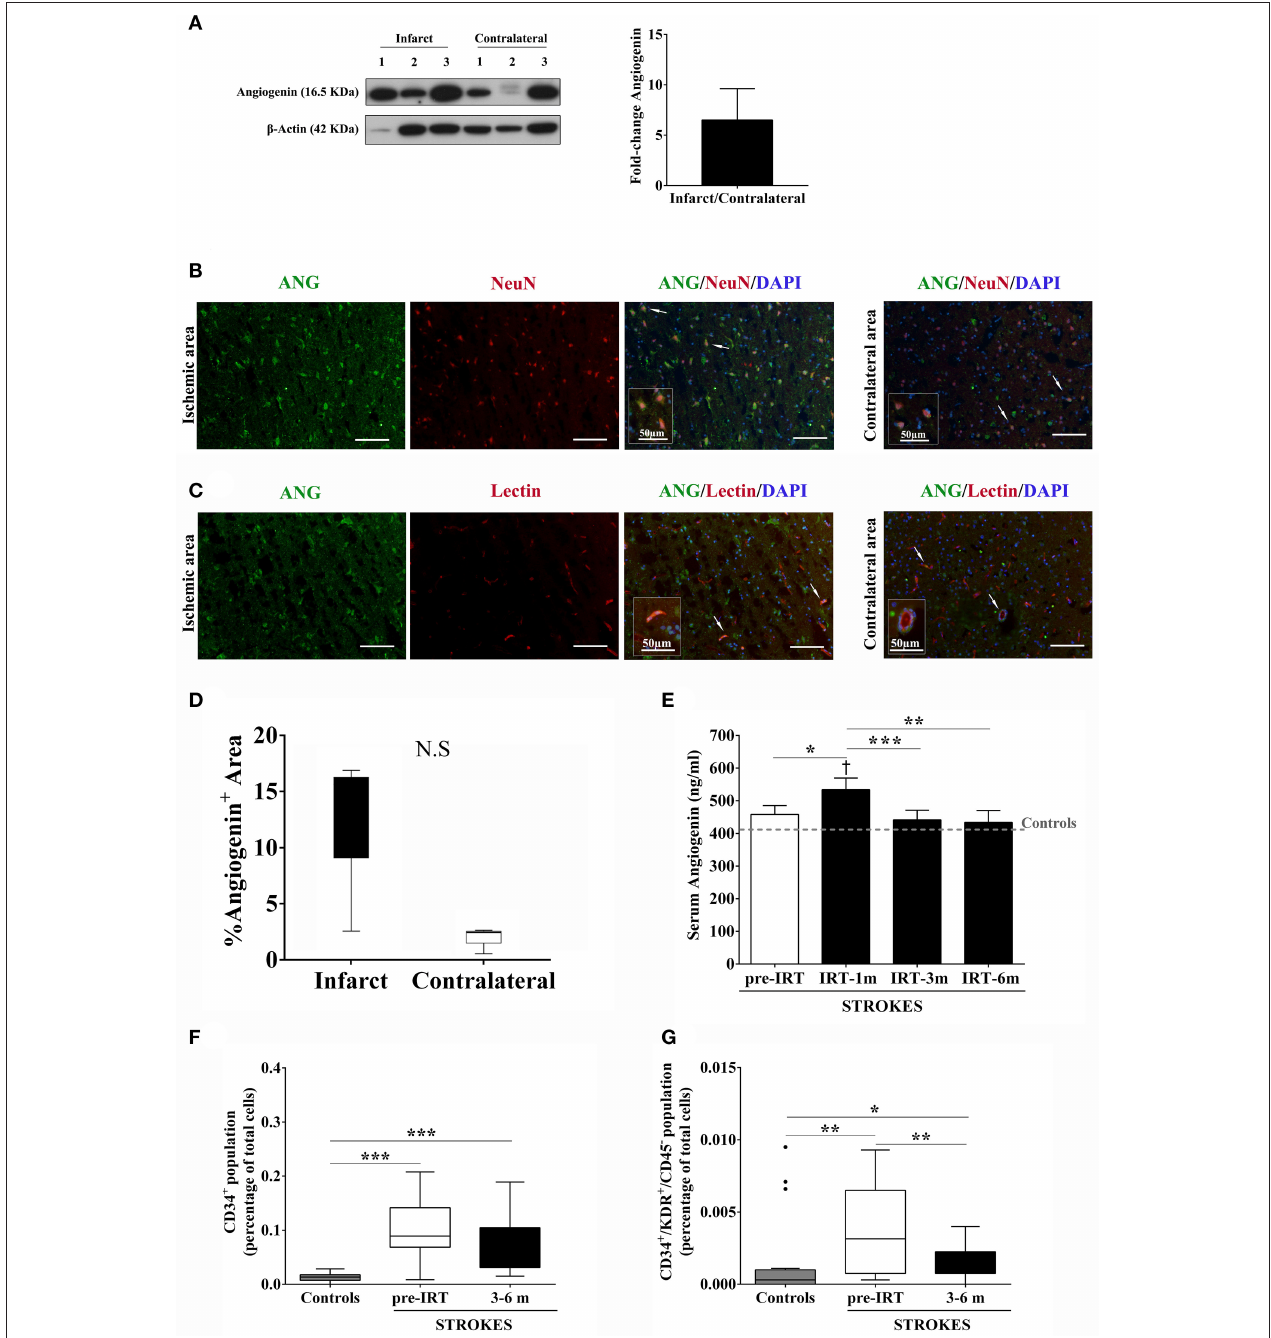
FIGURE 3 | Angiogenin and EPCs modulation after human stroke and rehabilitation. (A) Infarct tissue and contralateral brain homogenates ( ≤ 4 days) were analyzed by western blot for angiogenin ( n = 3). The densitometry results (arbitrary units) were corrected by the actin load and bar graph showing the angiogenin fold-change of the ipsilateral vs. contralateral signal. (B , C) Representative immunofluorescence images of ischemic and contralateral areas, respectively, of stroke patients showing angiogenin + /NeuN + cortical neurons and angiogenin + /lectin + vessels . (D) Box plots representing the percentage of the fluorescent Angiogenin + area in infarcted and non-infarcted brain samples from stroke patients ( n = 3). (E) Bar graphs showing the temporal profile of serum angiogenin levels during IRT. * p < 0.05; ** p < † p < 0.05 vs. Controls (Controls n = 13; Strokes in IRT n = 15–18). (F,G) Box plots representing cell populations with angiogenic potential 0.01, and *** p < 0.001; such as CD34 + and CD34 + /KDR + /CD45 − cell populations; * p < 0.05, ** p < 0.01, *** p < 0.001; Controls n = 17 and Strokes in IRT n = 15–17. Bar graphs are represented as the mean ± SEM , and box plots are represented as the median (IQR). NS, Non-significant; IRT, intensive rehabilitation therapy; m, month.